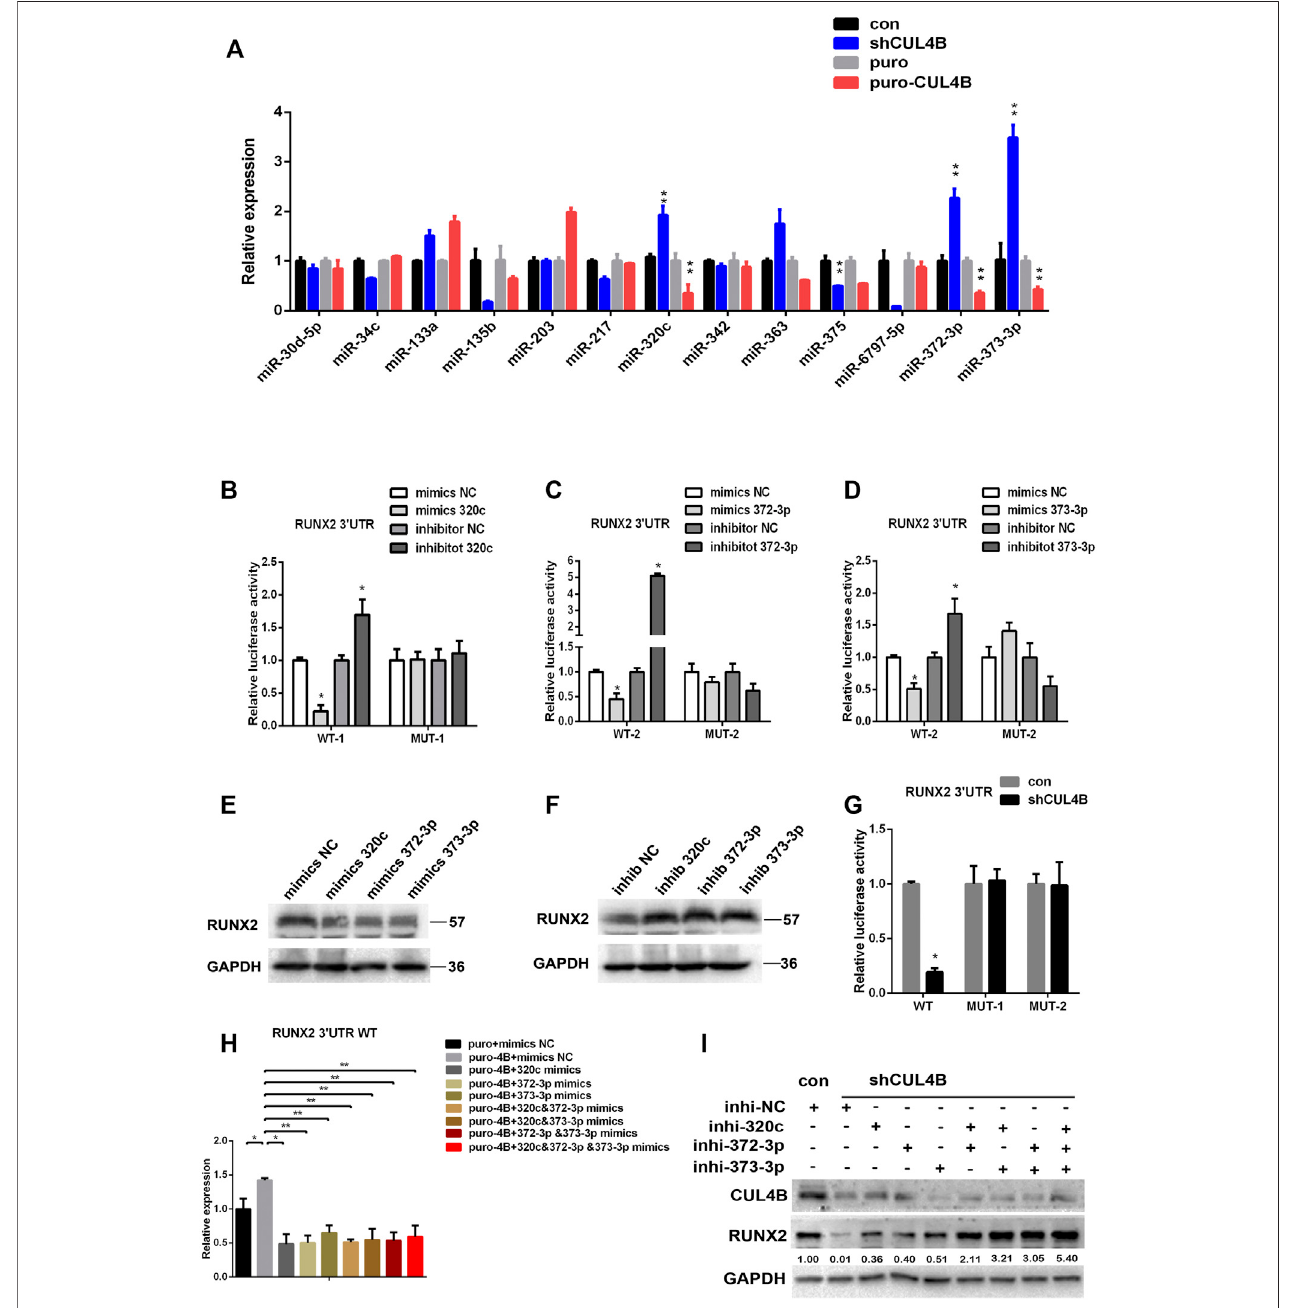
FIGURE 4 | CUL4B upregulates RUNX2 by repressing the expression of miR-320c/miR-371 – 373. (A) Expression of candidate miRNAs in CUL4B stable overexpressing (puro-CUL4B) or knockdown (shCUL4B) PDLSCs together with the corresponding control cells (puro or con) were determined by qRT-PCR. (B – D) Luciferase reporter assays of PDLSCs, which were transiently transfected with the wild-type construct of pmirGLO-RUNX2 3 ′ -UTR (WT), with mutant constructs of pmirGLO-RUNX23 ′ -UTR(MUT-1:mutatedmiR-320cbindingsite,MUT-2:mutatedmiR-372/3-3pbindingsite),withcontrolRNA(NC)orwithmiR-320candmiR- 372-3p/373-3p mimics. (E – F) Western blot analysis of RUNX2 expression in PDLSCs transfected with miR-320c and miR-372-3p/373-3p mimics or inhibitors and relative control RNAs (Mimics-NC or Inhibitor NC). (G) Luciferase reporter assays of CUL4B knockdown (shCUL4B) or control (con) PDLSCs that were transiently transfectedwithvectorscarryingwild-typeRUNX23 ′ UTR(WT)ormutantRUNX23 ′ UTR(MUT-1orMUT-2asabove). (H) Luciferasereporterassaysshowingdecreased luciferase activity of wild-type CUL4B overexpressing PDLSCs (puro-CUL4B) that was rescued by miR-320c and miR-372-3p/373-3p. (I) Western blotting analysis showing decreased RUNX2 expression in CUL4B knockdown PDLSCs (shCUL4B) was rescued by 320c and miR-372-3p/373-3p repression. Band intensities underneaththegelimagesin (I) weremeasuredusingImageJsoftware(NIH,Bethesda,MD)andarepresentedasfoldchange.Allquanti fi cationanalyseswerebasedon independent triplicate experiments. Error bars represent SD. Statistical comparisons were made using a two-tailed unpaired t-test, * p < 0.05, ** p < 0.01 compared with the negative control.